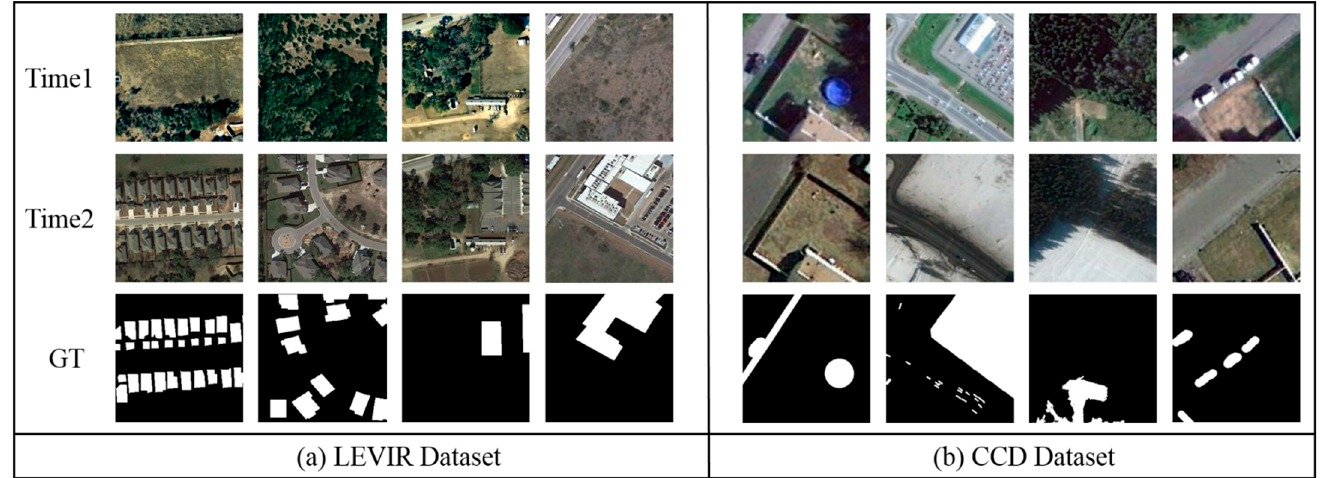
Figure 7. Bitemporal images and ground truth maps from the LEVIR and the CCD datasets. The first row represents the image at Time1. The second row represents the image at Time2. The third row represents the ground truth map.